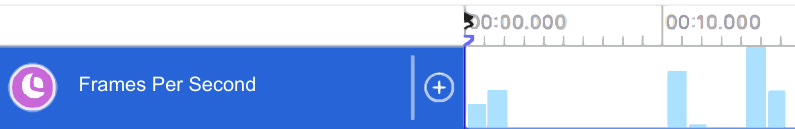
Figure 5. Example of measuring FPS in Xcode’s Core Animations Instruments